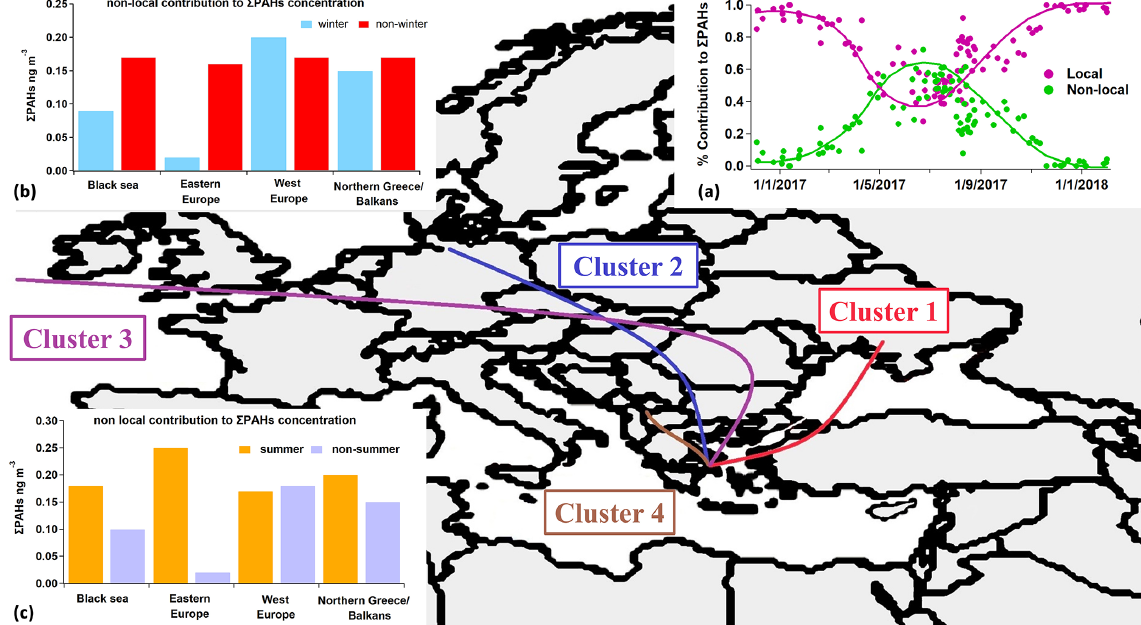
Figure 4. The four dominant clusters of backward trajectories, Black Sea (cluster 1: red), eastern Europe (cluster 2: blue), western Europe (cluster 3: purple), and northern Greece/Balkans (cluster 4: brown). Panel (a) shows the local and non-local relative source contributions during the study period. Panels (b, c) show the non-local contribution to (cid:54) PAHs concentration according to the respective air mass